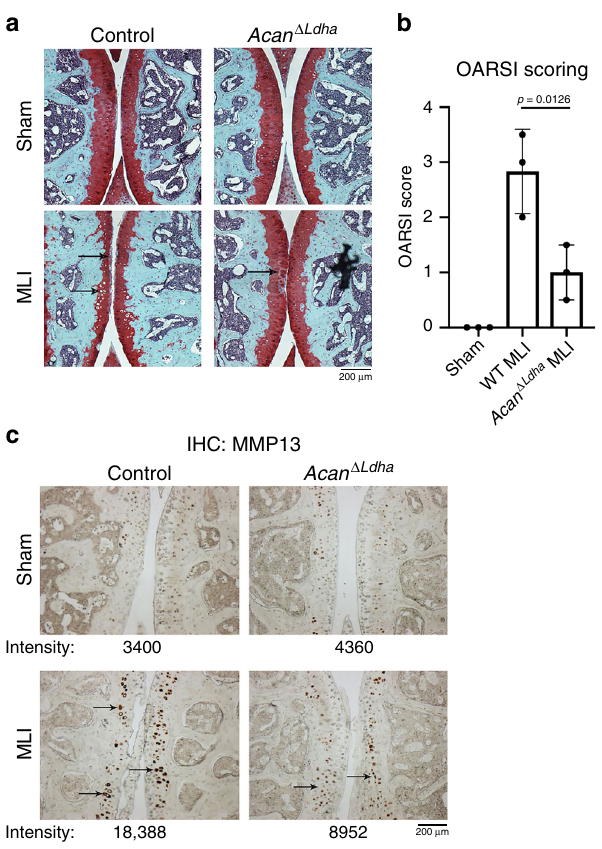
Fig. 7 Deletion of LDHA in chondrocytes in vivo is protective against OA. a MLI surgery was performed on 10-week-old Acan Δ /Ldha male mice placed on tamoxifen diet to induce recombination. Sham surgery was performed on contralateral leg and used as control. 10 weeks post surgery mice were sacri fi ced and joints were collected for histology. Safranin-O staining was performed of the MLI and sham joints. b OARSI scoring of two safranin-O stained sections per mouse were averaged ( n = 3 mice for control, n = 3 mice for Acan Δ /Ldha ). Bars represents mean ± S.D. from one experiment out of two comparing littermates. One-way ANOVA followed by Tukey ’ s test multiple comparisons test was utilized for statistical analysis. c IHC was performed for MMP13, with arrows pointing to examples of stained chondrocytes. Representative images are displayed with pixel intensity of stain quanti fi ed under each image. a , c Scale bar = 200 μ